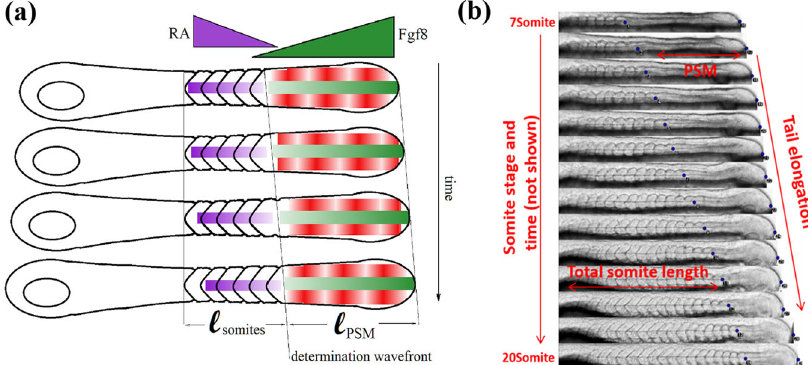
Fig. 1 Schematics of somitogenesis. a The Clock and Wavefront model: antagonistic gradient of Fgf8 (originating from the posterior PSM, green) and RA (originating from the somites, violet) de fi ne a wavefront which interacts with a particular phase of the segmentation clock (in the PSM, red) to generate somites at periodic times and positions. b Kymograph of somitogenesis from 7 to 20 somites. The tail elongates at a constant rate V tail while the PSM shrinks at a roughly constant rate V PSM resulting in a somite wavefront propagating 5 (in the lab frame) at a rate V front = V tail − V PSM